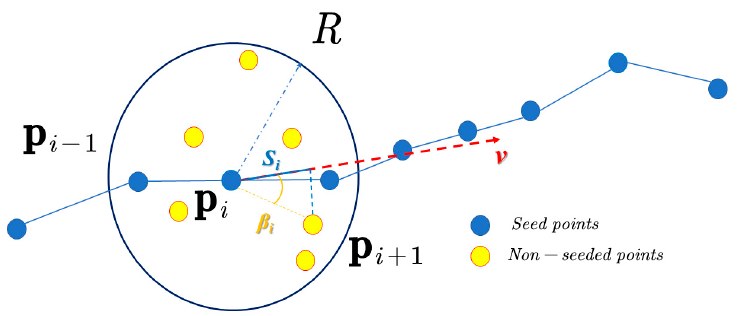
Figure 8. Seed-growth tracking.